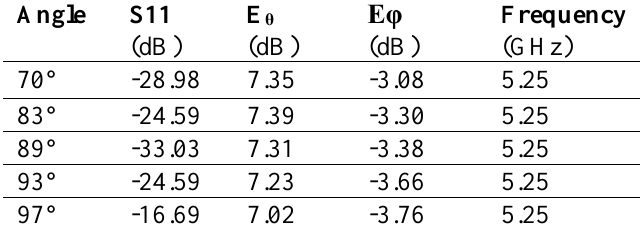
Table 4. Simulation results for angle changes on point B